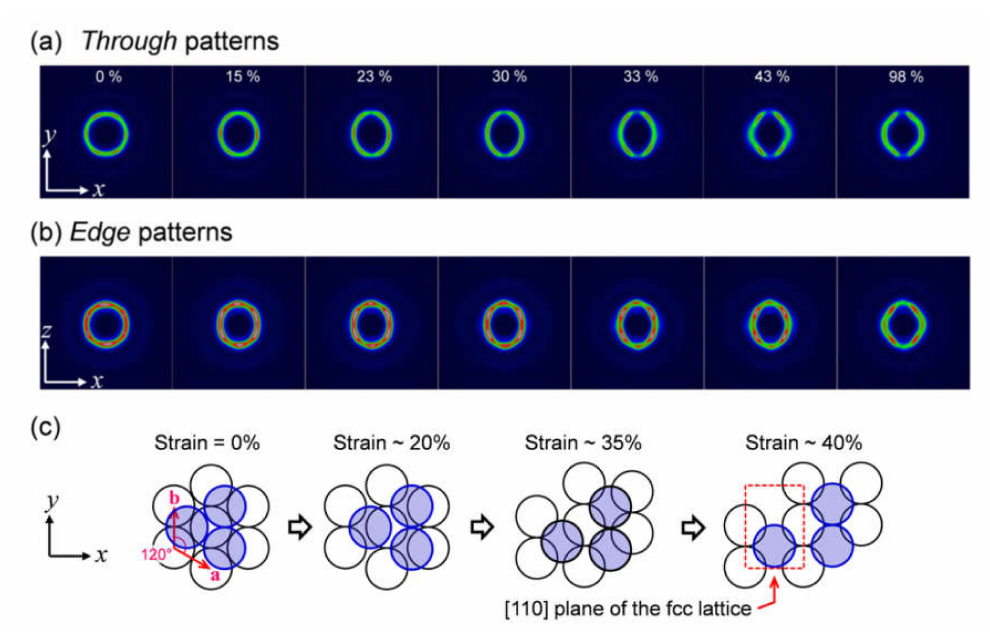
Figure 3. USAXS patterns of the through plane ( a ) and edge plane ( b ). The model of the deformation mechanism of the SPNP lattice is presented in panel ( c ), in which the close-packed layers lie on the through plane at the initial state. The lattice vectors of the two-dimensional hexagonal lattice in the close-packed plane are represented by a and b in panel ( c ). Reproduced with permission [19]. Copyright 2016,